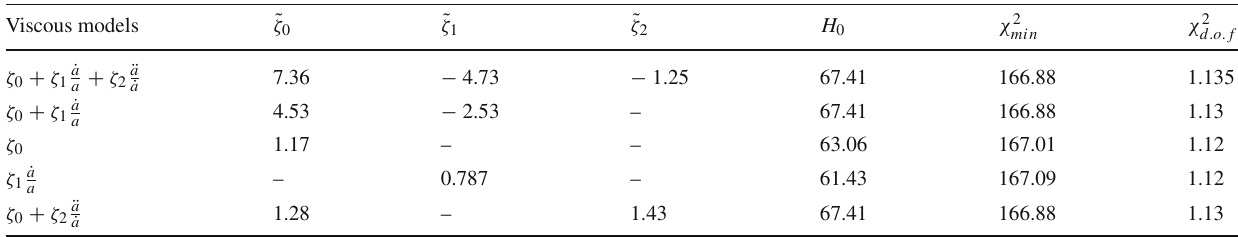
Table 3 Best estimates of the Bulk viscous parameters, H 0 and also χ 2 minimum value corresponding to the different cases of ζ for high = χ 2 min redshift. χ 2 , where n = 150, the number of data and m is d . o . f n − m Viscous models